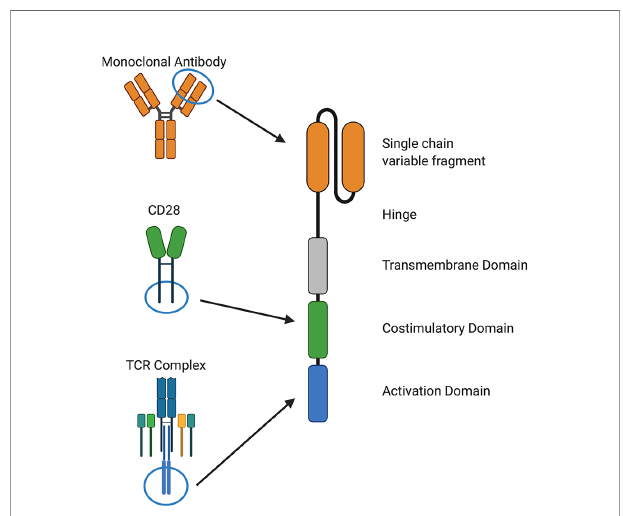
FIGURE 1 | Components of chimeric antigen receptors. CARs recognize a cell surface antigen via a single chain variable fragment (scFv) from a monoclonal antibody or a ligand and signal through costimulatory domains derived from and CD28, 4-1BB, or other molecules and an activation domain derived from CD3 z . Structural components, such as hinge and transmembrane domains derived from CD28, CD8 a , or other molecules, are also important for CAR